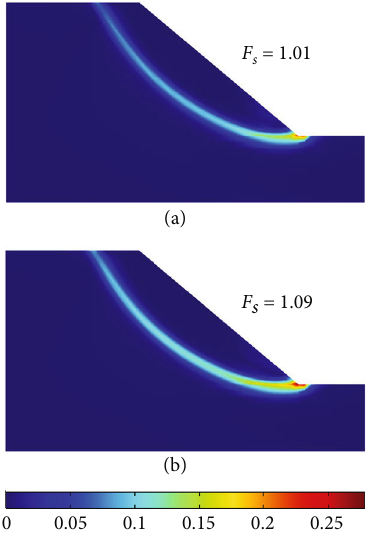
Figure 11: The stability factor and corresponding equivalent plastic strain after 5 days of rainfall. (a) Case considering the coupling e ff ect of pore water pressure and pore water gravity. (b) Case considering only the e ff ect of pore water